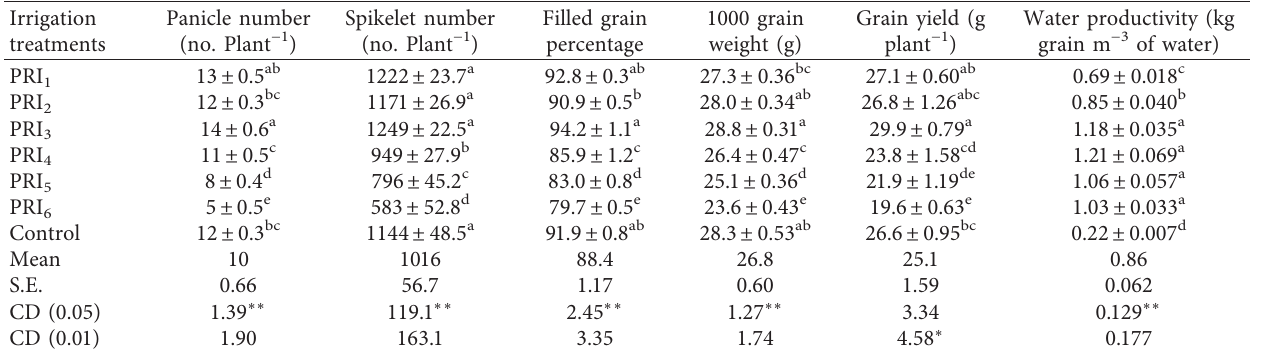
Table 5: Changes in yield, yield attributes, and water productivity of PMK ( R ) 3 rice by split root experiment. Irrigation Panicle treatments